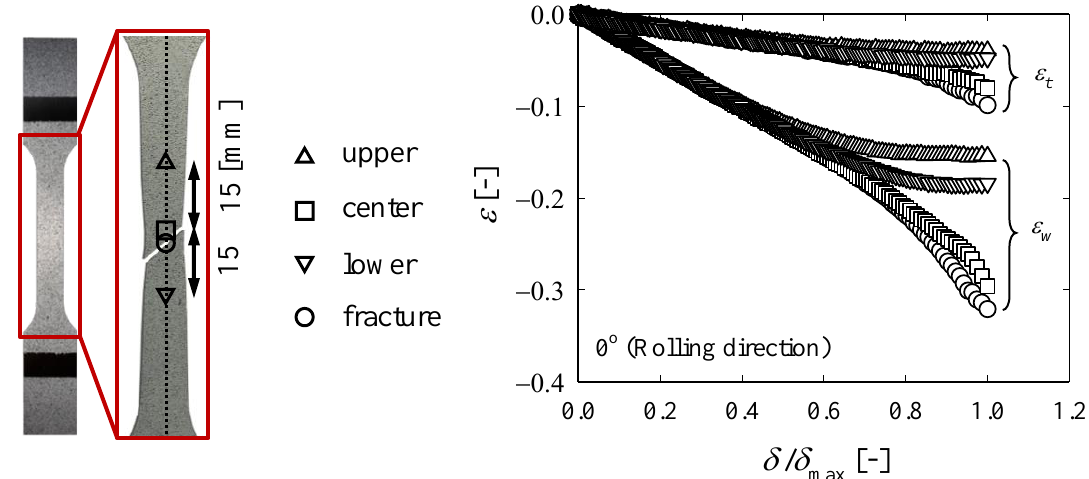
Figure 4. Evolution of ε w and ε t for various location from the uniaxial tensile tests at rolling direction (RD) specimen.